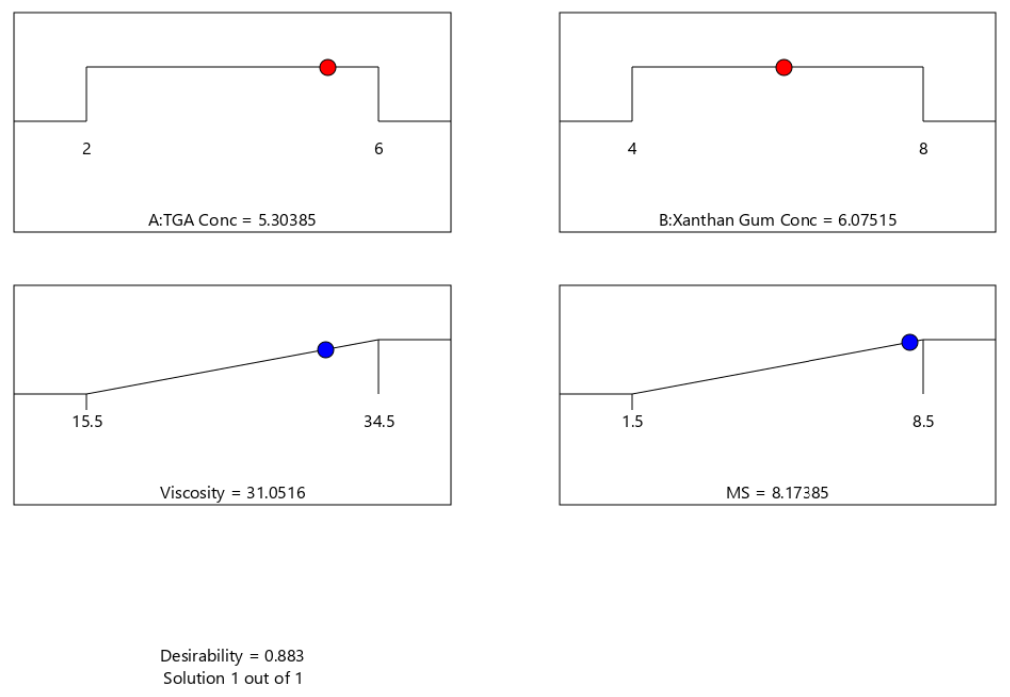
Figure 3. Desirability plot and optimized concentrations to prepare TXG (TGA conc — Moles/L; Xanthan Gum Conc — g/L; Viscosity — mPa-s; MS-